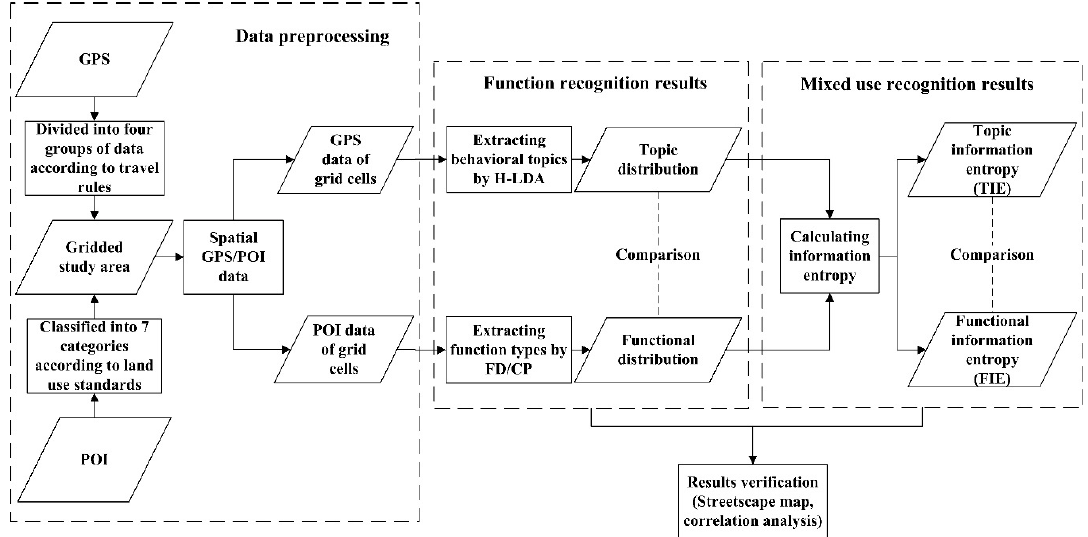
Figure 3. Process for identifying and analyzing urban function and mixed use.